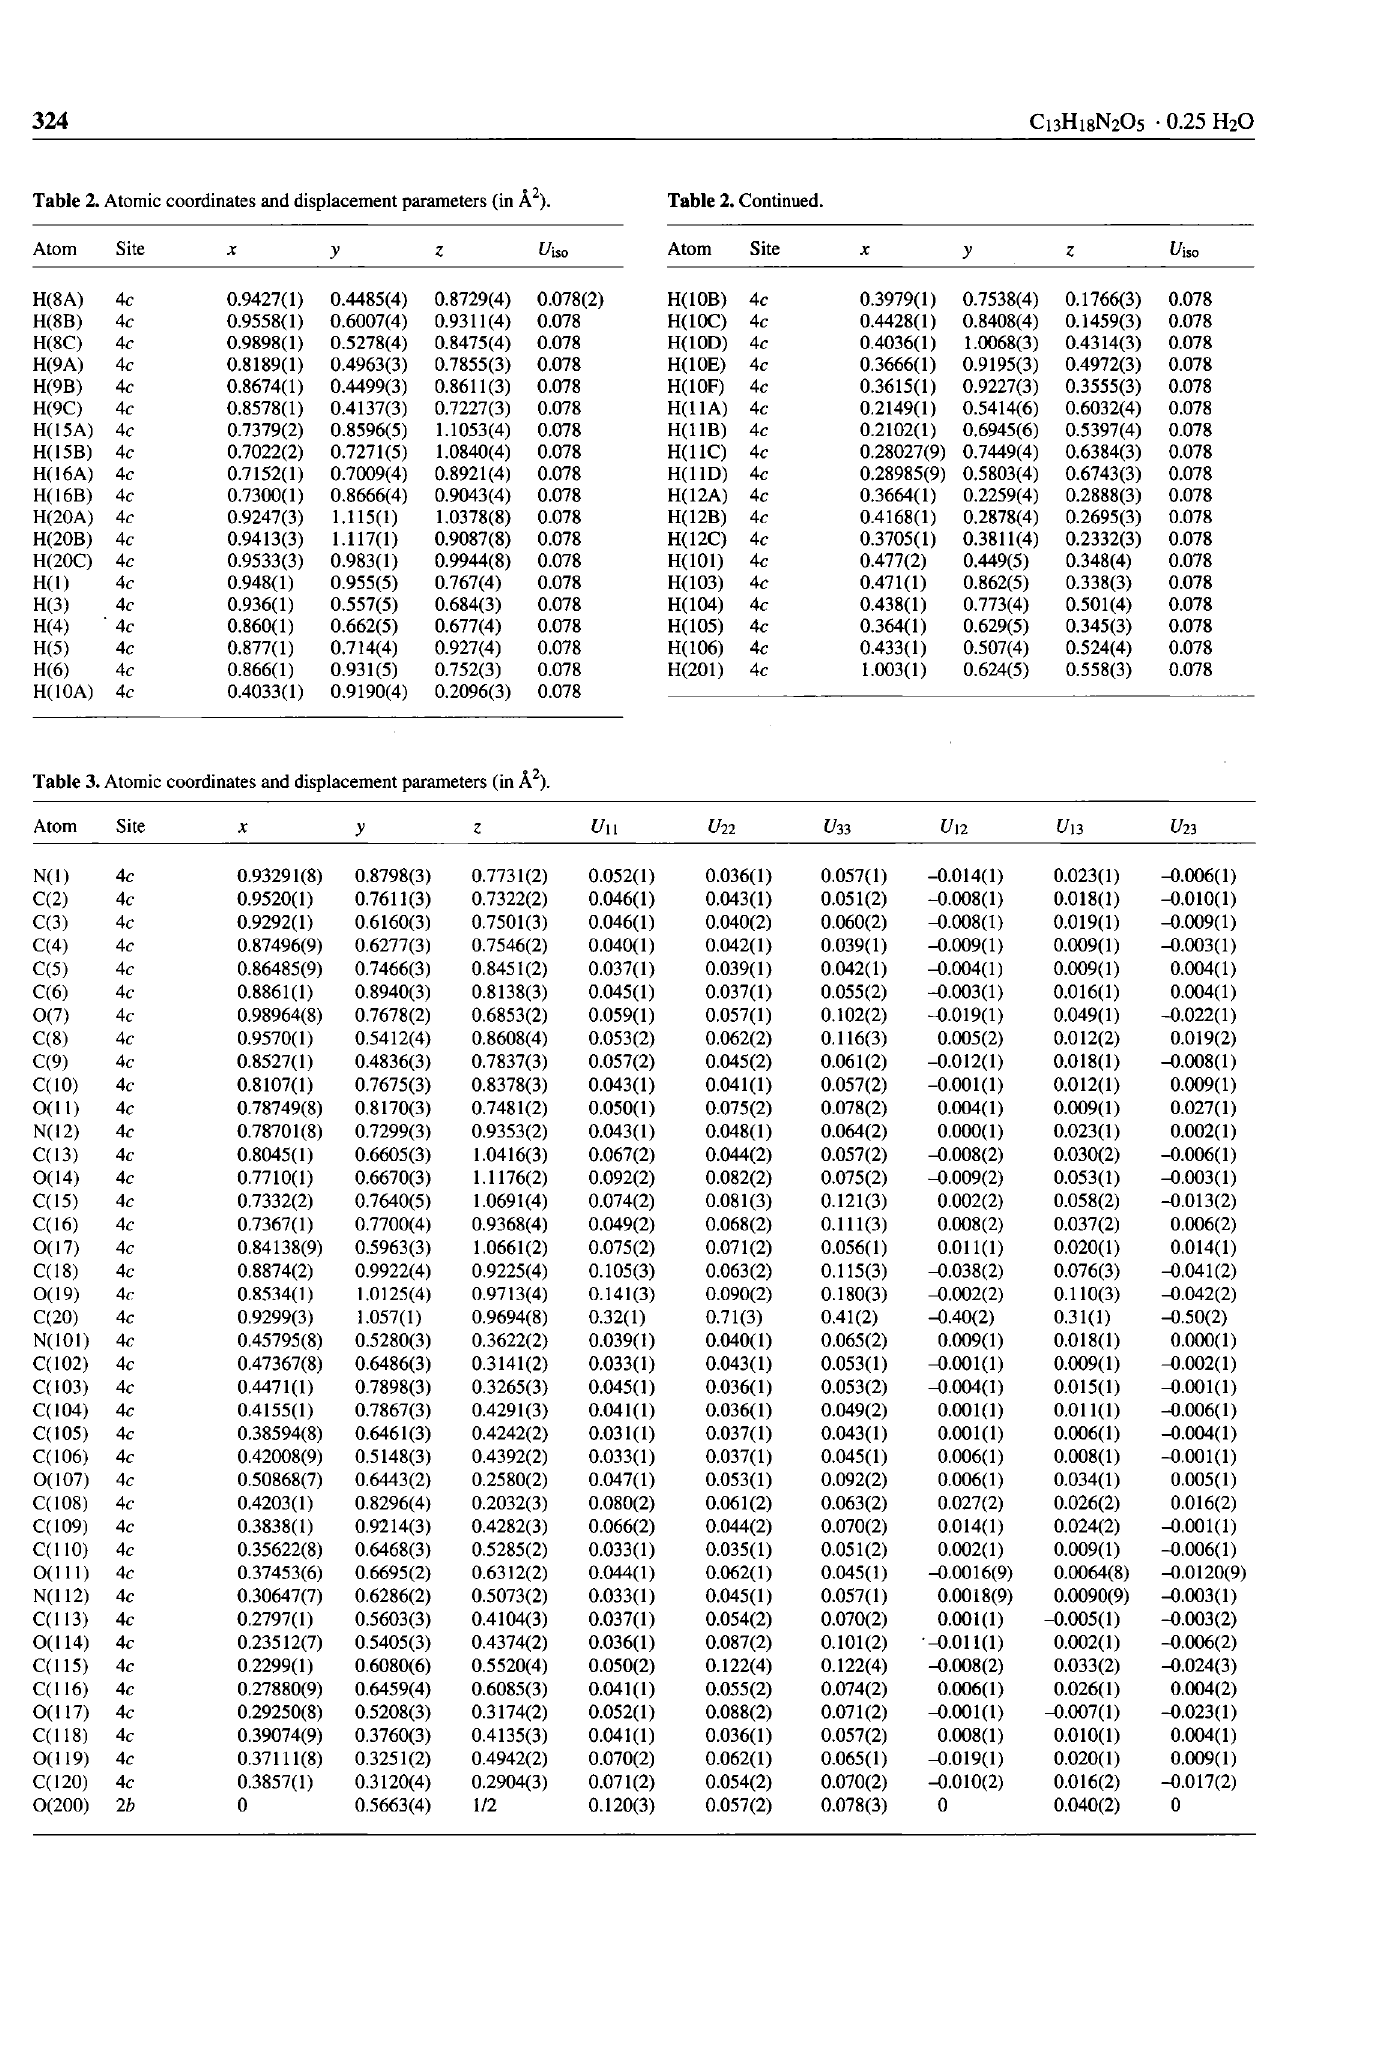
Table 3. Atomic coordinates and displacement parameters (in Â 2